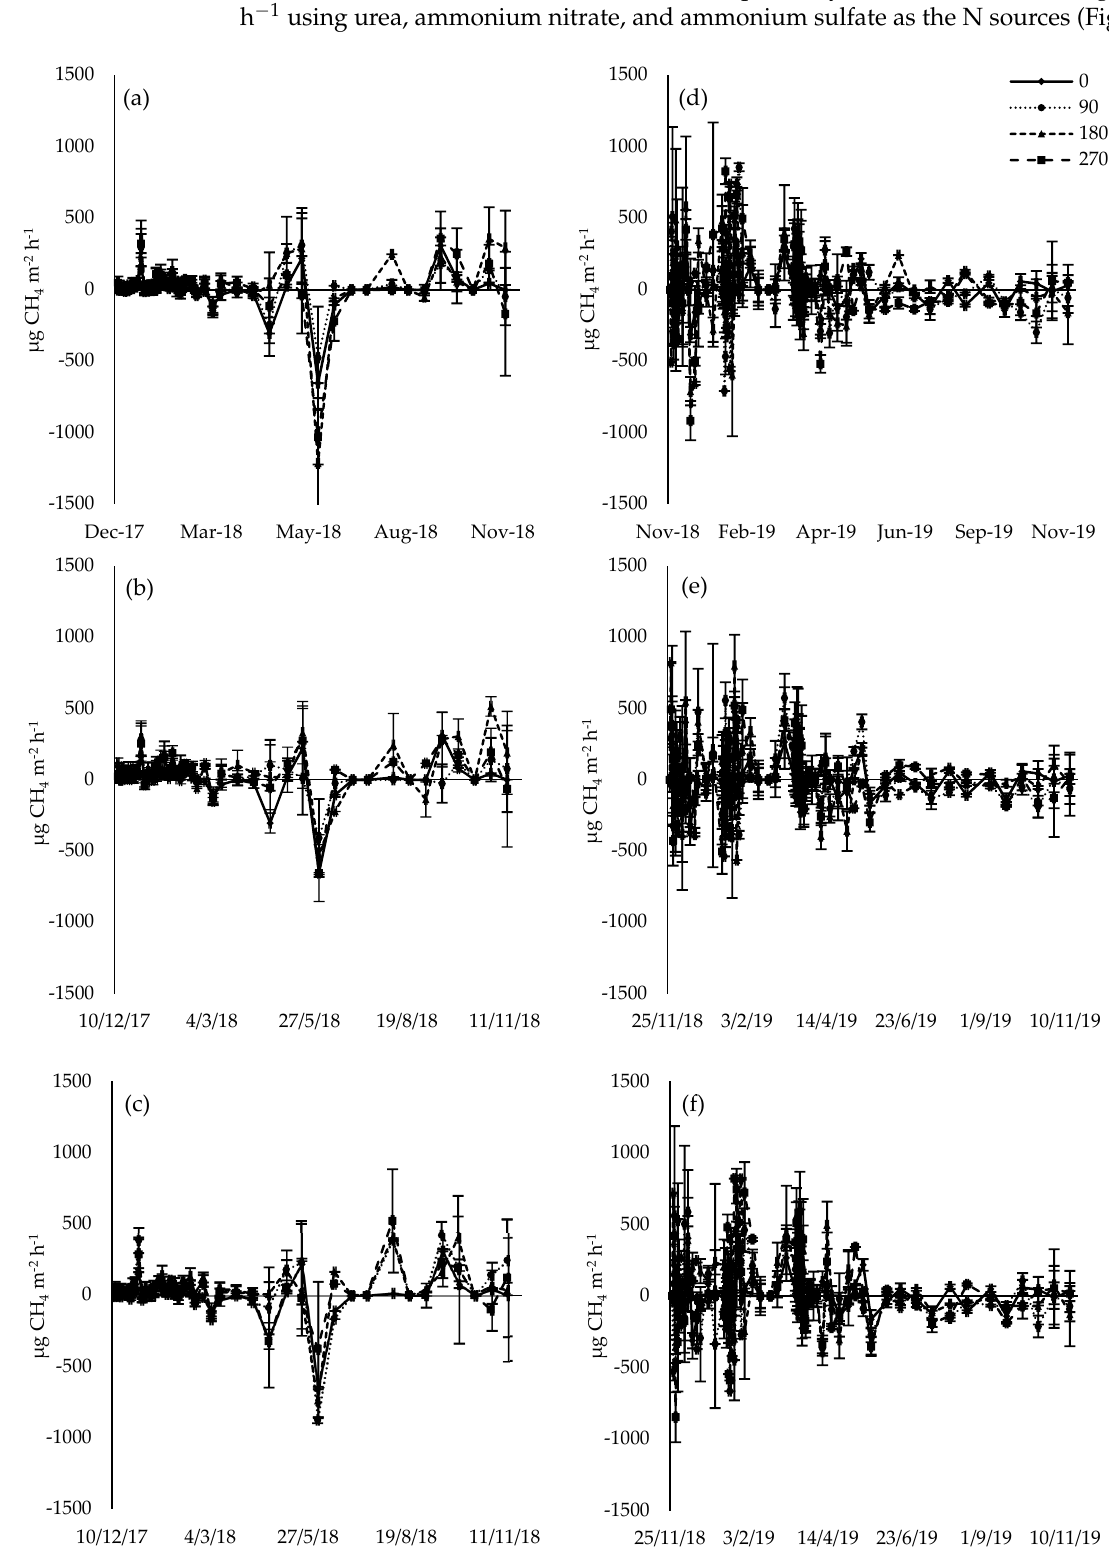
Figure 3. Descriptive of average CH 4 fluxes ( μ g m − 2 h − 1 ) from pastures managed with N fertilizers in two experiments. ( a ) Urea, ( b ) ammonium nitrate, and ( c ) ammonium sulfate in experiment 1. ( d ) Urea, ( e ) ammonium nitrate, and ( f ) ammonium sulfate in experiment 2.